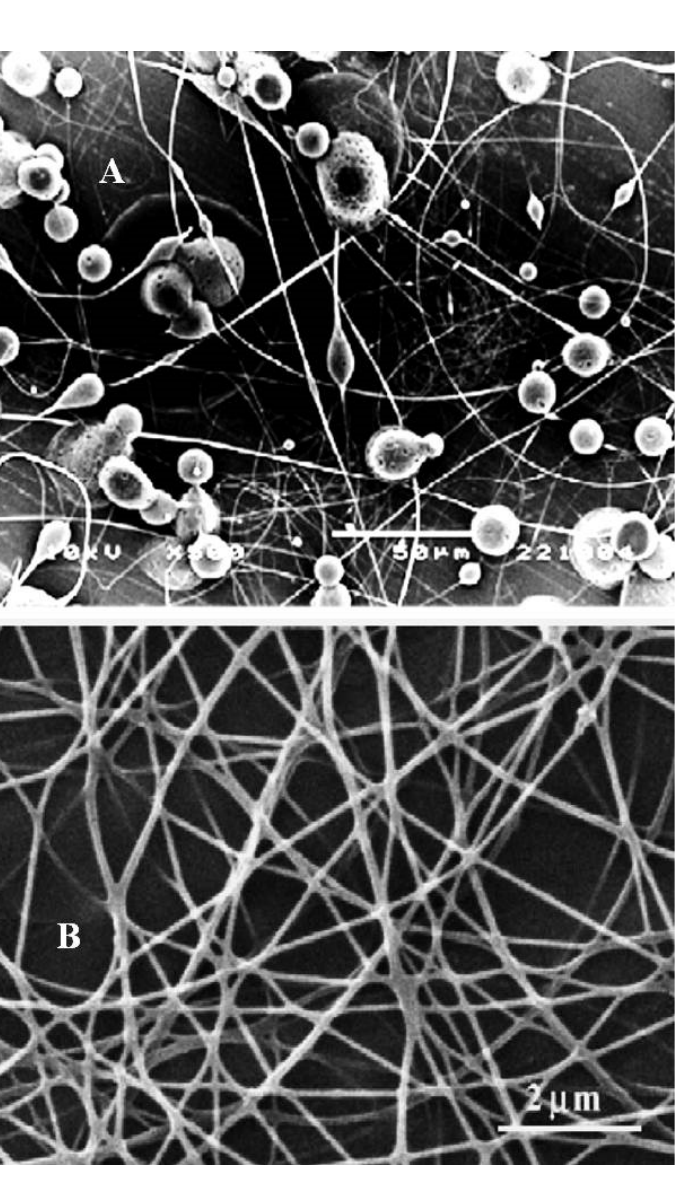
Figure 1. SEM image of electrospun pure chitosan 5% in 90% glacial acetic acid ( A ) and CH/PVP nanofiber (25/75 wt. %) with a weight ratio of 90 % ( v / v ) in acetic acid ( B ).